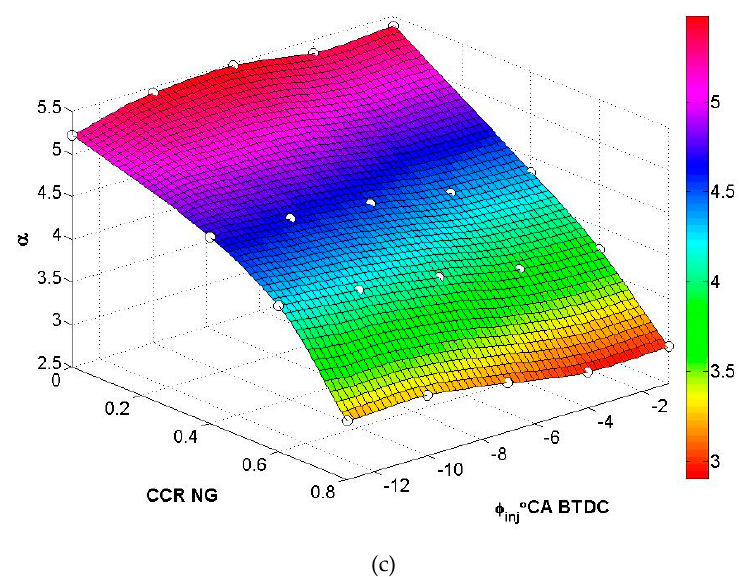
Figure 11. Influence of dual-fuel CCR NG portion and ϕ inj on α ( n = 2000 rpm ) : ( a ) HLM; ( b ) MLM; ( c ) LLM. The dots in the graph represent the experimental data. The changes in the parameter ( 𝛼 ) are attuned with the changes in the parameter (𝜂 (cid:3036) ) arising from the same factors of CCR NG and 𝜑 (cid:3036)(cid:3041)(cid:3037) (see Figure 12 compared to Figure 11).